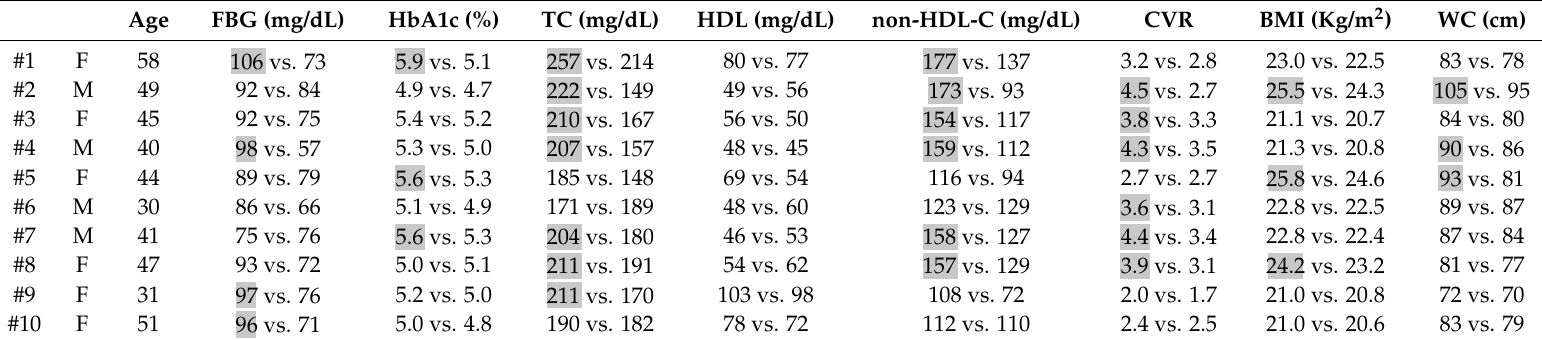
Table 3 summarizes the results obtained for each study participant. Table 3. Individual metabolic and body mass parameters of 10subjects treated for 75 days with the ABA-rich food